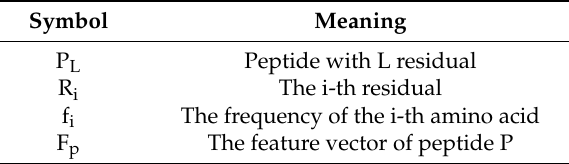
Table 2. The symbols used in the present